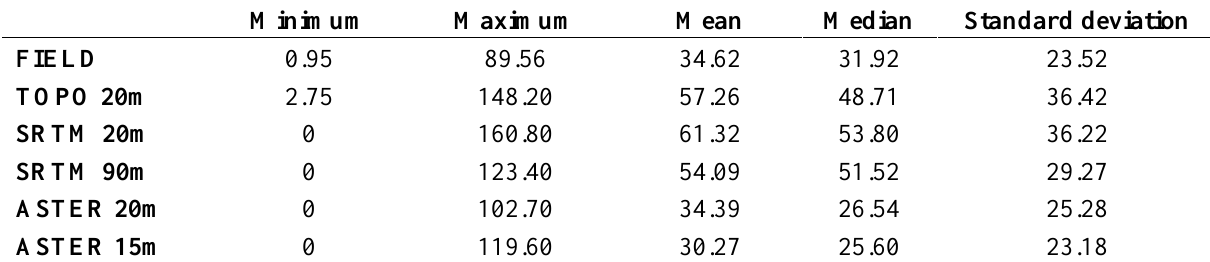
Table 4. Univariate statistics for RUSLE LS factor at 152 locations derived from field data and from the 5